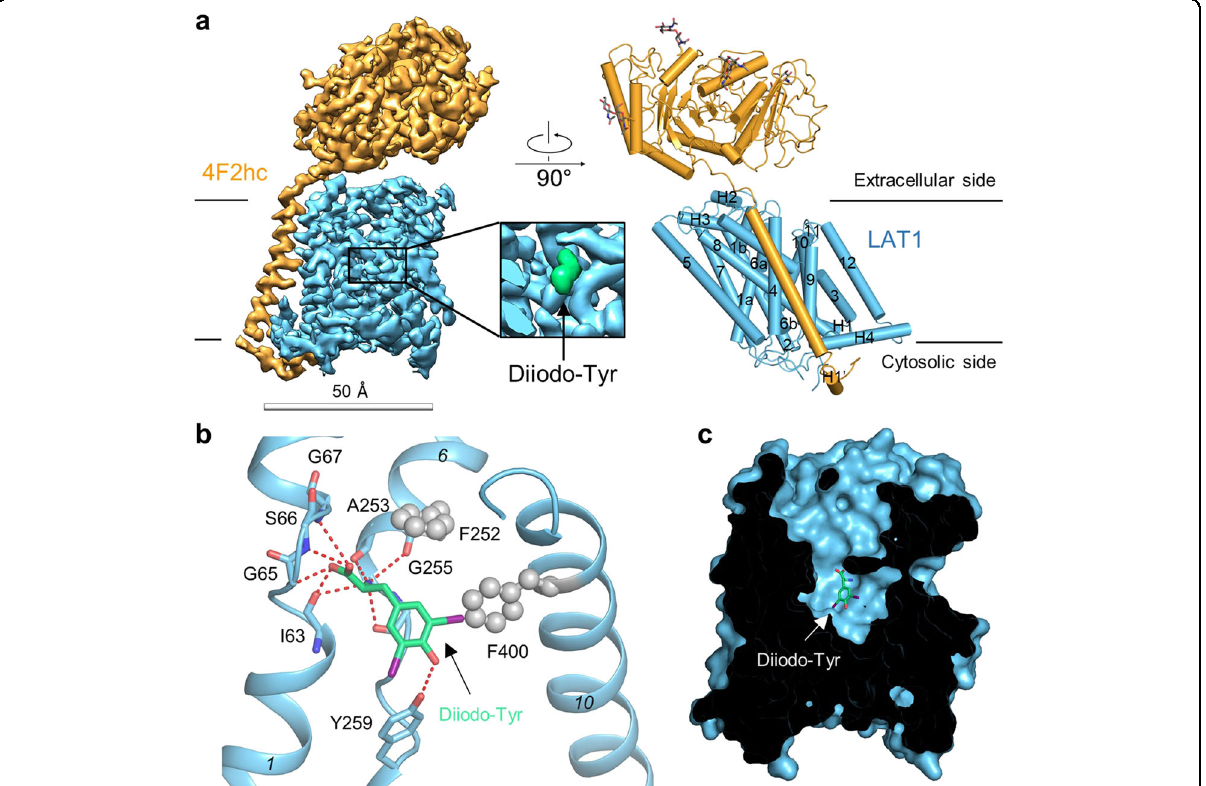
Fig. 3 Overall structure of the LAT1-4F2hc bound with Diiodo-Tyr. a The overall structure of the LAT1-4F2hc bound with Diiodo-Tyr. The structure on the left is the EM map of the complex. The structure on the right is the overall structure of the complex. The glycosylation moieties are shown as sticks. H, helix. 4F2hc and LAT1 are colored orange and blue, respectively. b Diiodo-Tyr binding mode in LAT1. c LAT1 has a broad extracellular vestibule above